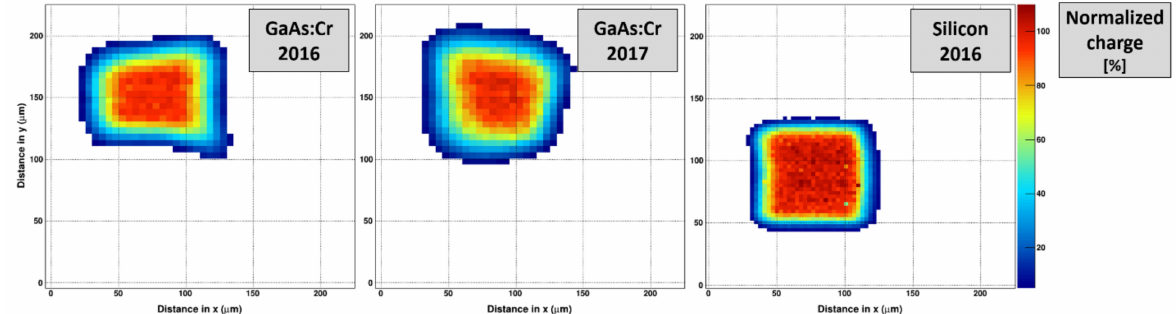
Figure 18. Collected charge in a single pixel as function of the position in x-y direction of a 20 keV pencil beam raster scanned with a step size of 5 µ m for three different sensors: ( left ) GaAs:Cr 2016 ( center ) GaAs:Cr 2017 ( right ) Silicon. The z-axis indicates the normalized integrated charge. The minimum of the z-axis is fixed to 5% for a better comprehensibility as it removes contributions from scattered photons and auto fluorescence.